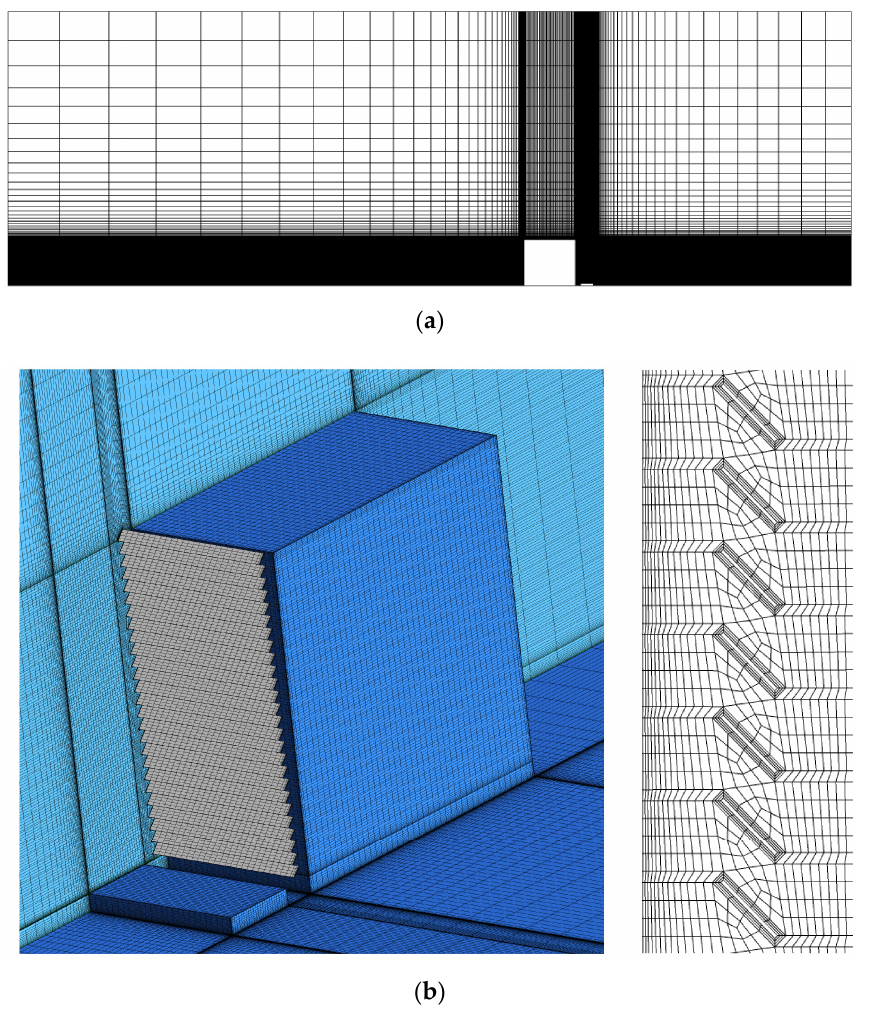
Figure 6. Dimensions of the computational domain for CFD simulation.